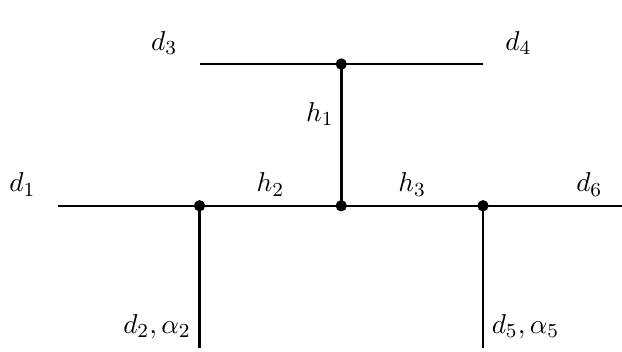
Figure 4 . 6-point conformal block in the non-linear